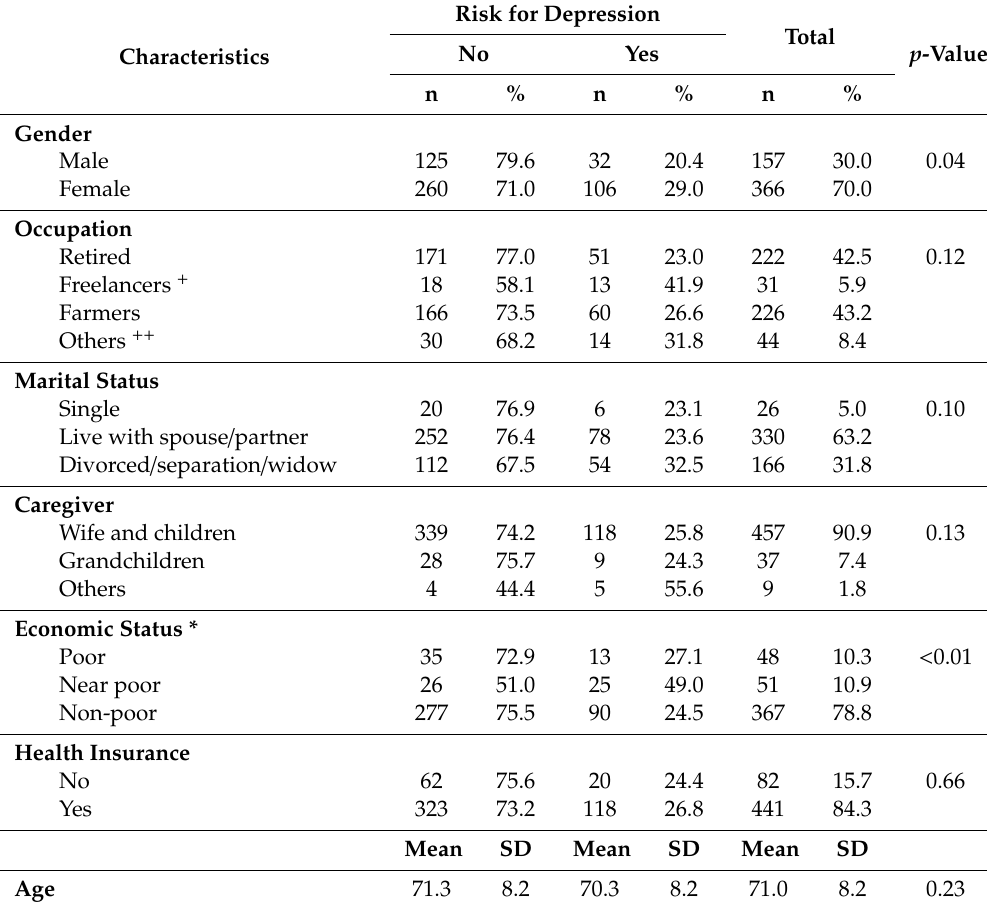
Table 2. Risk for depression according to socio-economic status of